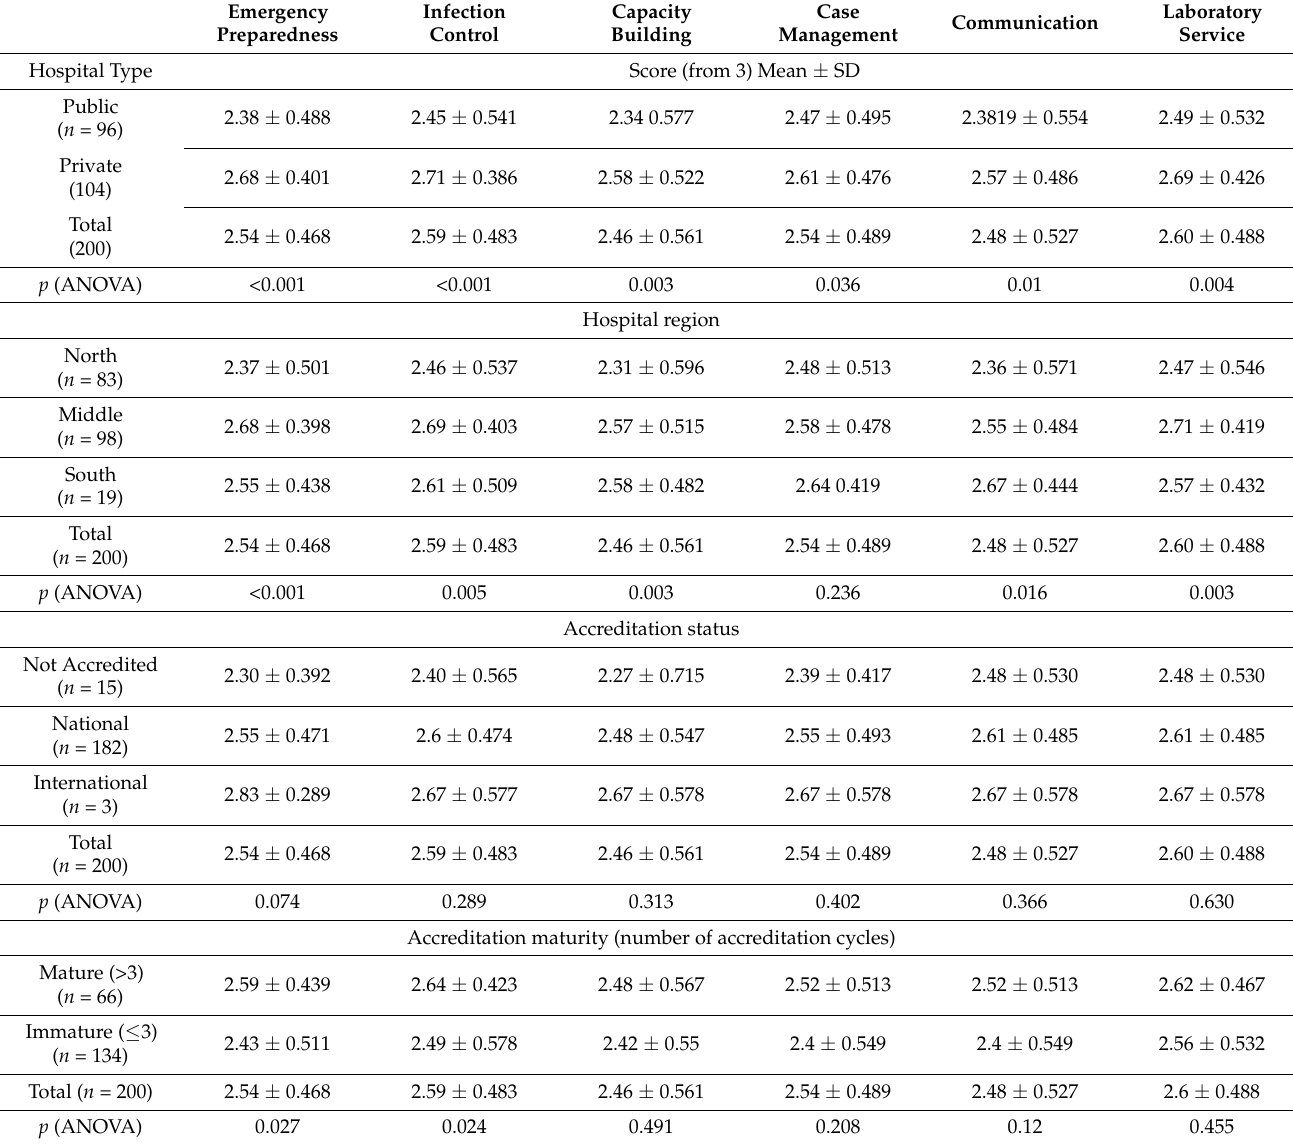
Table 4. Stratification of participants’ response scores for the patient safety focus areas according to hospital type, location, accreditation status, and accreditation maturity